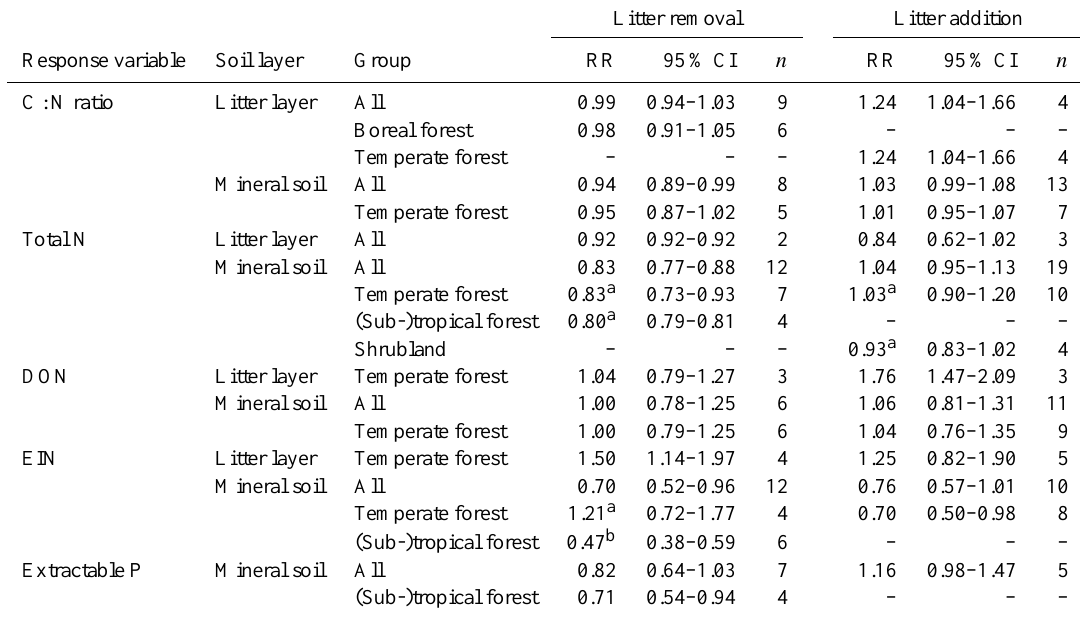
Table 3. Effects of litter removal and litter addition on soil nutrient cycling parameters of different ecosystems, where DON is dissolved organic nitrogen and EIN is extractable inorganic nitrogen. For each response variables, the responses of the ecosystems denoted by different superscript letter differed significantly ( P < 0 .